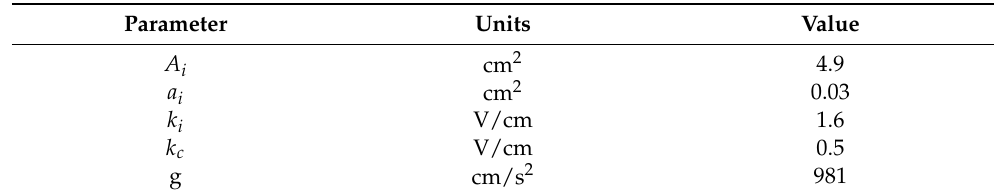
Table 3. Parameter values for the quadruple tank simulation.